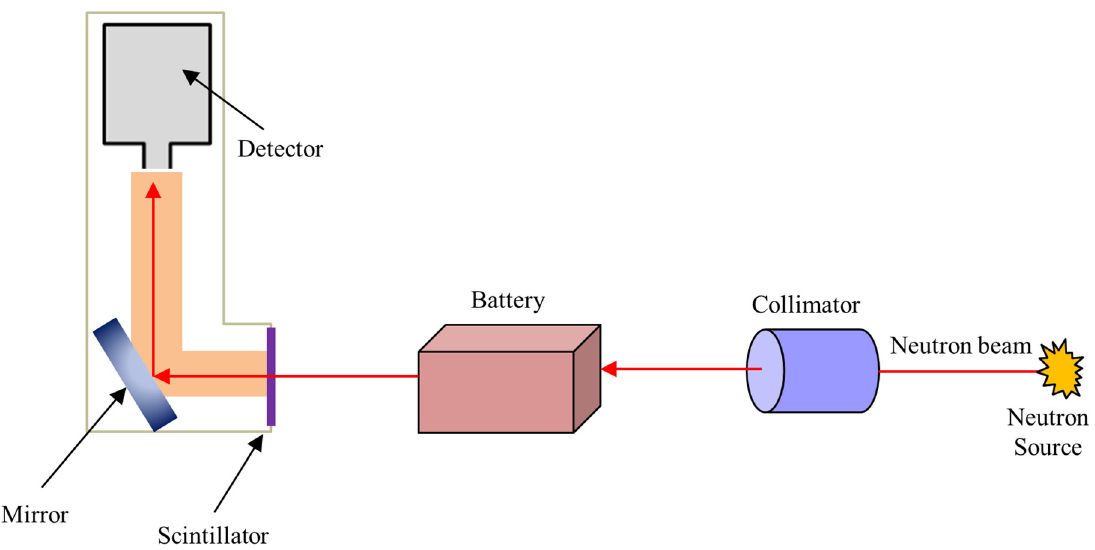
Figure 7. Experimental set-up of the NI for in situ/Operando quantifications (adapted with permission from Ref. [67]. 2018 Elsevier).